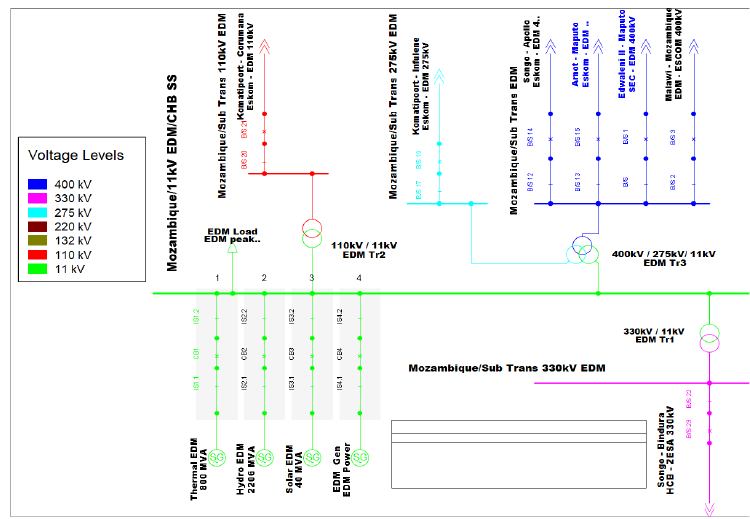
Figure 3. Proposed power system network model in Mozambique. Energies 2023 , 16 , x FOR PEER REVIEW